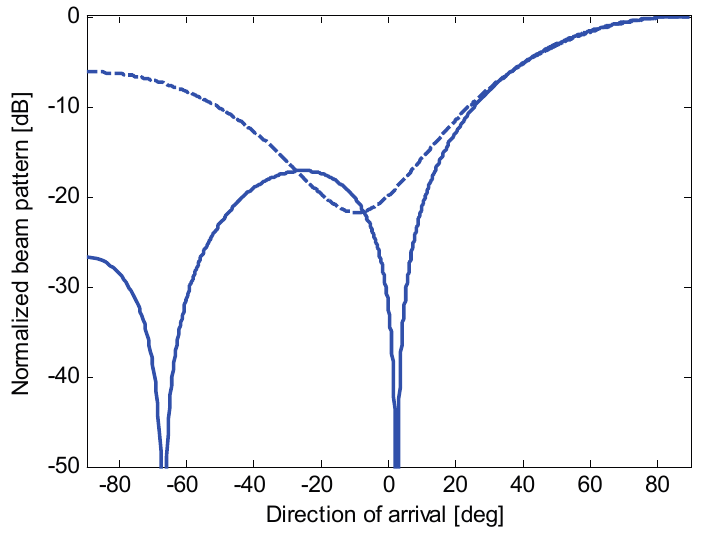
Figure 17. Nominal beam pattern (solid line) and actual beam pattern (dashed line) for beamforming with optimum complex weights when f s = 5 kHz and U = 1 for an end-fire array of 8